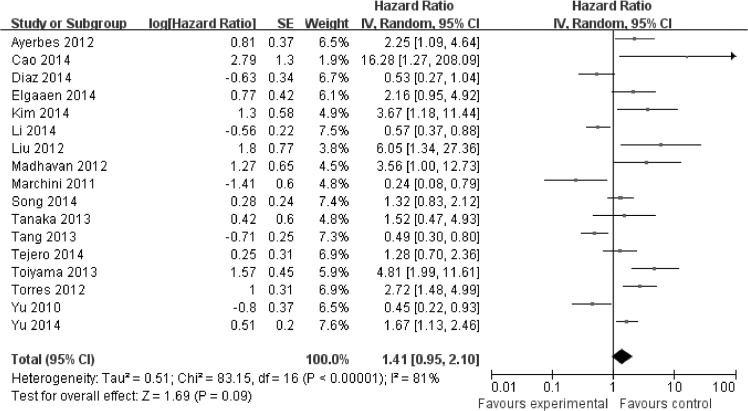
Meta-analysis evaluating miR-200c expression and overall survival (OS) in cancer patients.